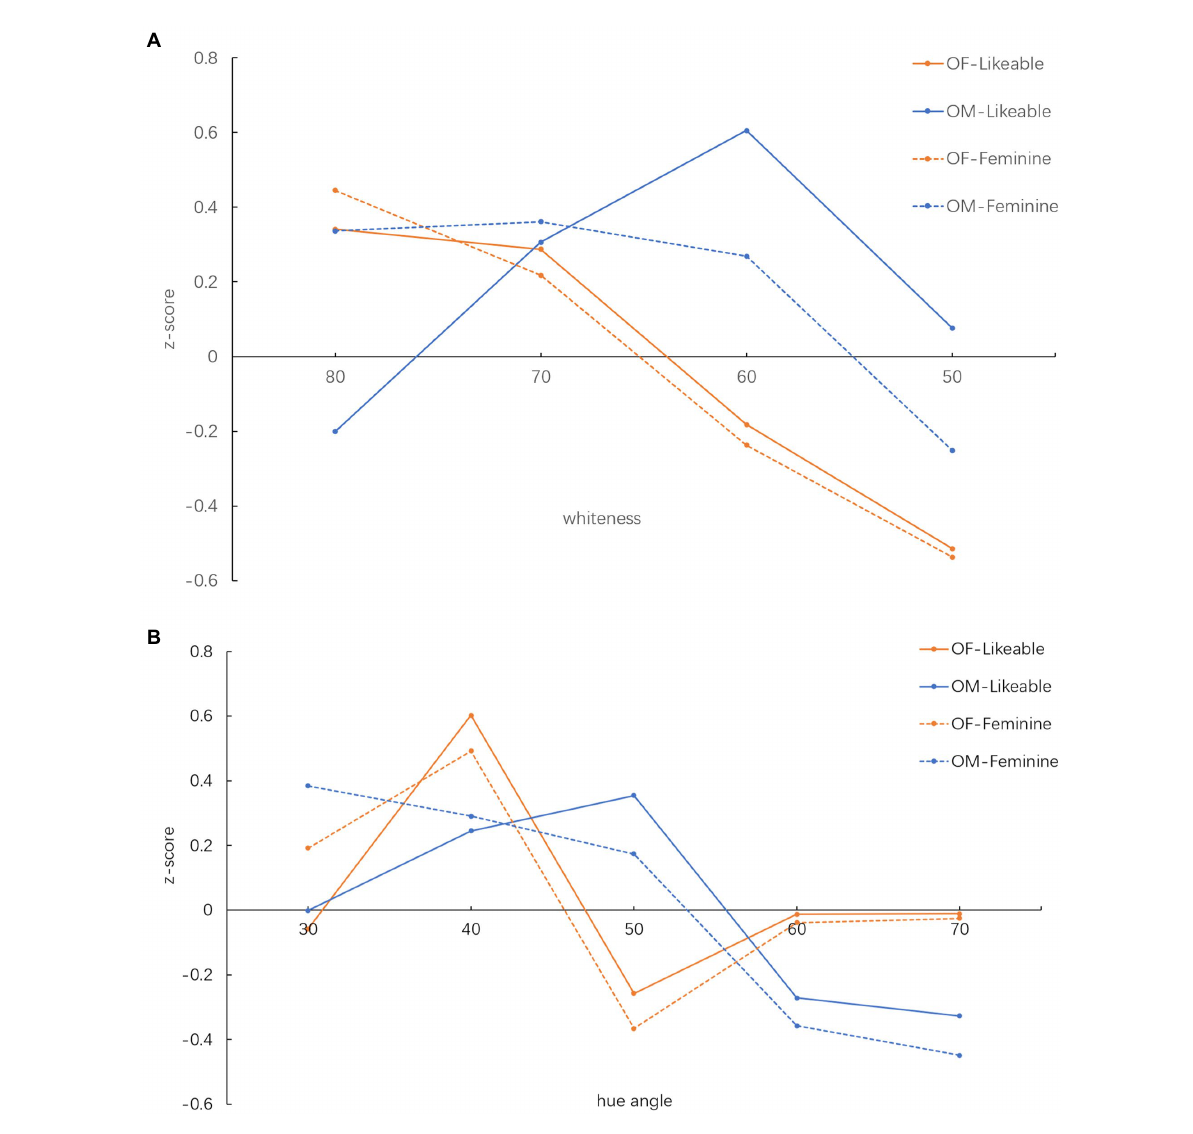
FIGURE 2 The z-score of OF and OM images with different (A) , whiteness and (B) , hue